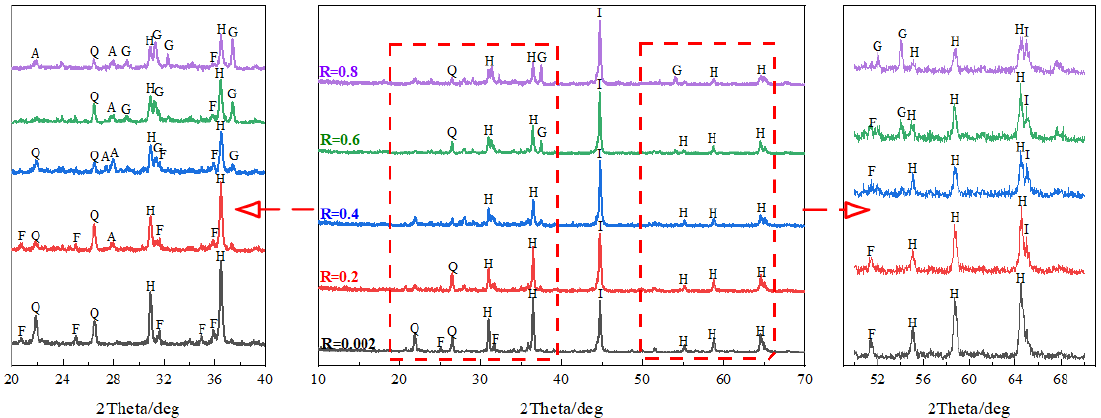
Figure 6. Effects of binary basicity (w(CaO)/w(SiO 2 )) on the pre-reduction indices (Reduction at 1000 °C for 60 min, with a C/Fe mass ratio of 1.50).